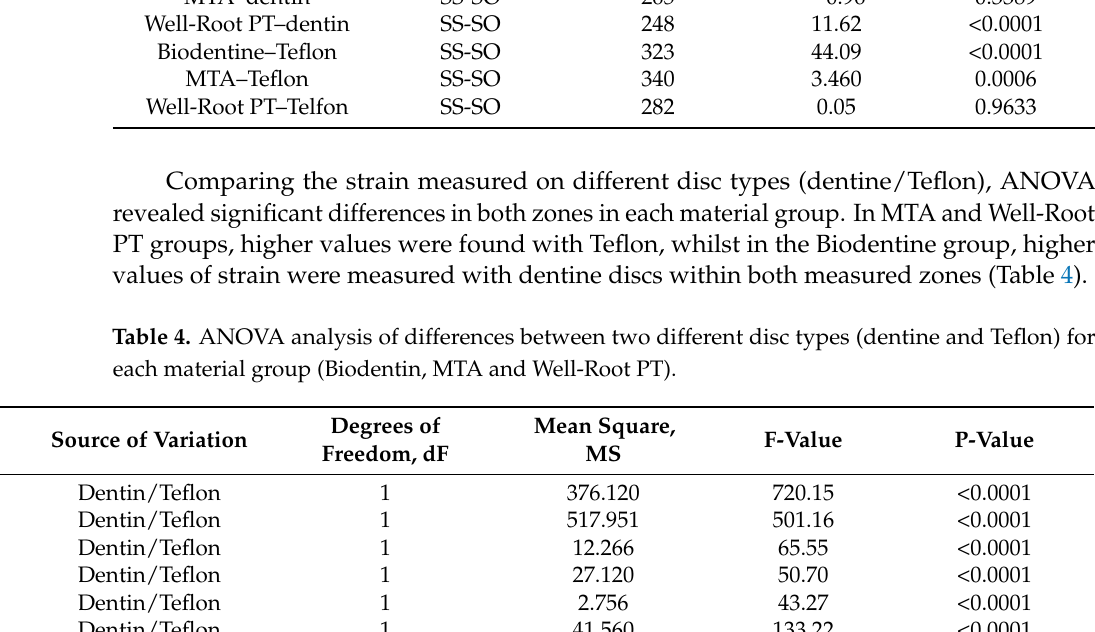
Table 4. ANOVA analysis of differences between two different disc types (dentine and Teflon) for each material group (Biodentin, MTA and Well-Root PT).